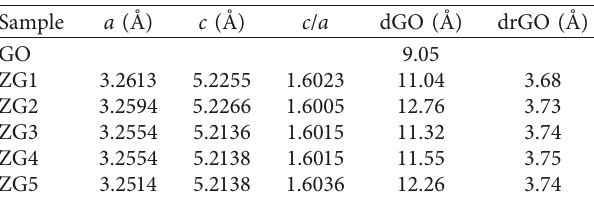
Figure 5: (a) The characteristic peaks for graphene oxide ( ), reduced graphene oxide ( ), and water intercalated between graphene sheets ( ∗ ) with increasing zinc content are shown. The spectra for samples ZG2 to ZG5 have been magnified for clarity, as indicated by the numbers on the rightmost part. (b) The characteristic spectra for zinc oxide exhibit a hexagonal wurtzite structure. The peaks for zinc precursor are also present. Table 2: The complete list of lattice parameters a and c for ZnO and the interlayer spacing for GO 001 and